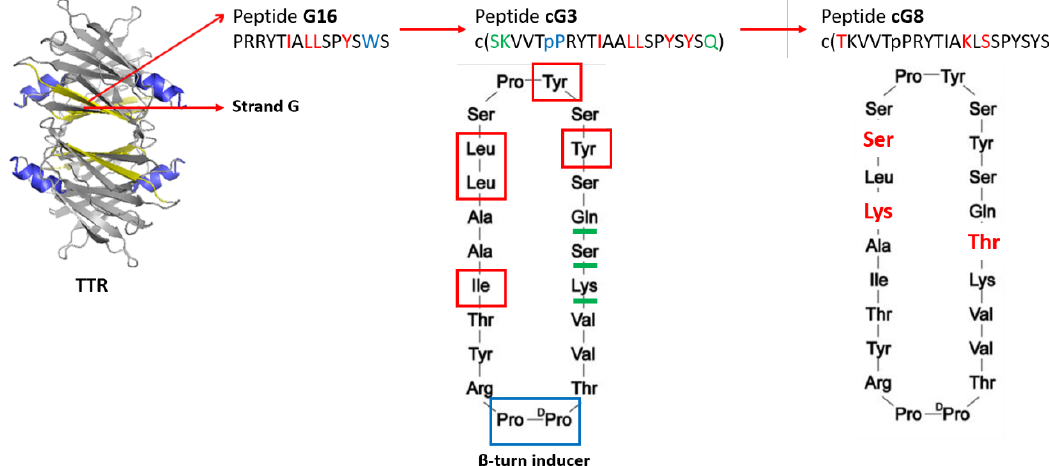
Figure 4. Schematic representation of the design development of peptide cG8, as first TTR-derived peptide inhibitor.